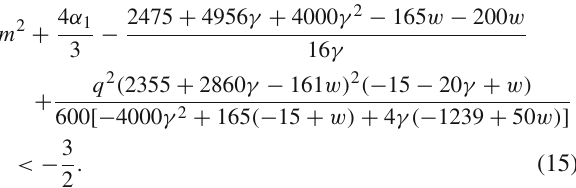
Fig. 5 3D plot of the allowed region for the superconducting phase transition at the zero